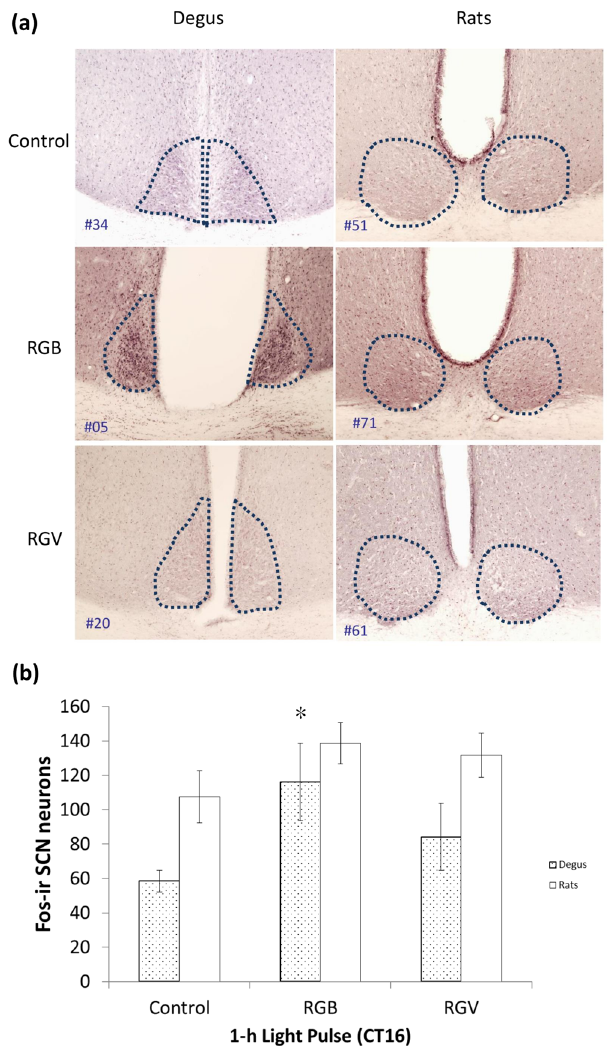
Figure 8. Effect of light on the suprachiasmatic nuclei. ( a ) Representative photomicrographs showing Fos- immunoreactivity in the suprachiasmatic nuclei (SCN) of degus (left panel) and rats (right panel) under each experimental condition: control animals, which received no light pulse (darkness), and after 1-hour light pulse at CT16 with RGB or RGV lights. The SCN area is delimited by dotted lines. ( b ) Quantification of Fos- immunoreactive neurons (counted on the left part of the SCN) in the control group (no light pulses, n = 9 degus; 4 rats), the RGB group (pulsed for 1 h with RGB light at CT16, n = 7 degus; 4 rats) and the RGV group (pulsed for 1 h with RGV light at CT16, n = 7 degus; 4 rats). Data are expressed as the mean ± SEM. * Indicates significant differences compared to control degus (Kruskal-Wallis, p = 0.030; Mann-Whitney U test, p =